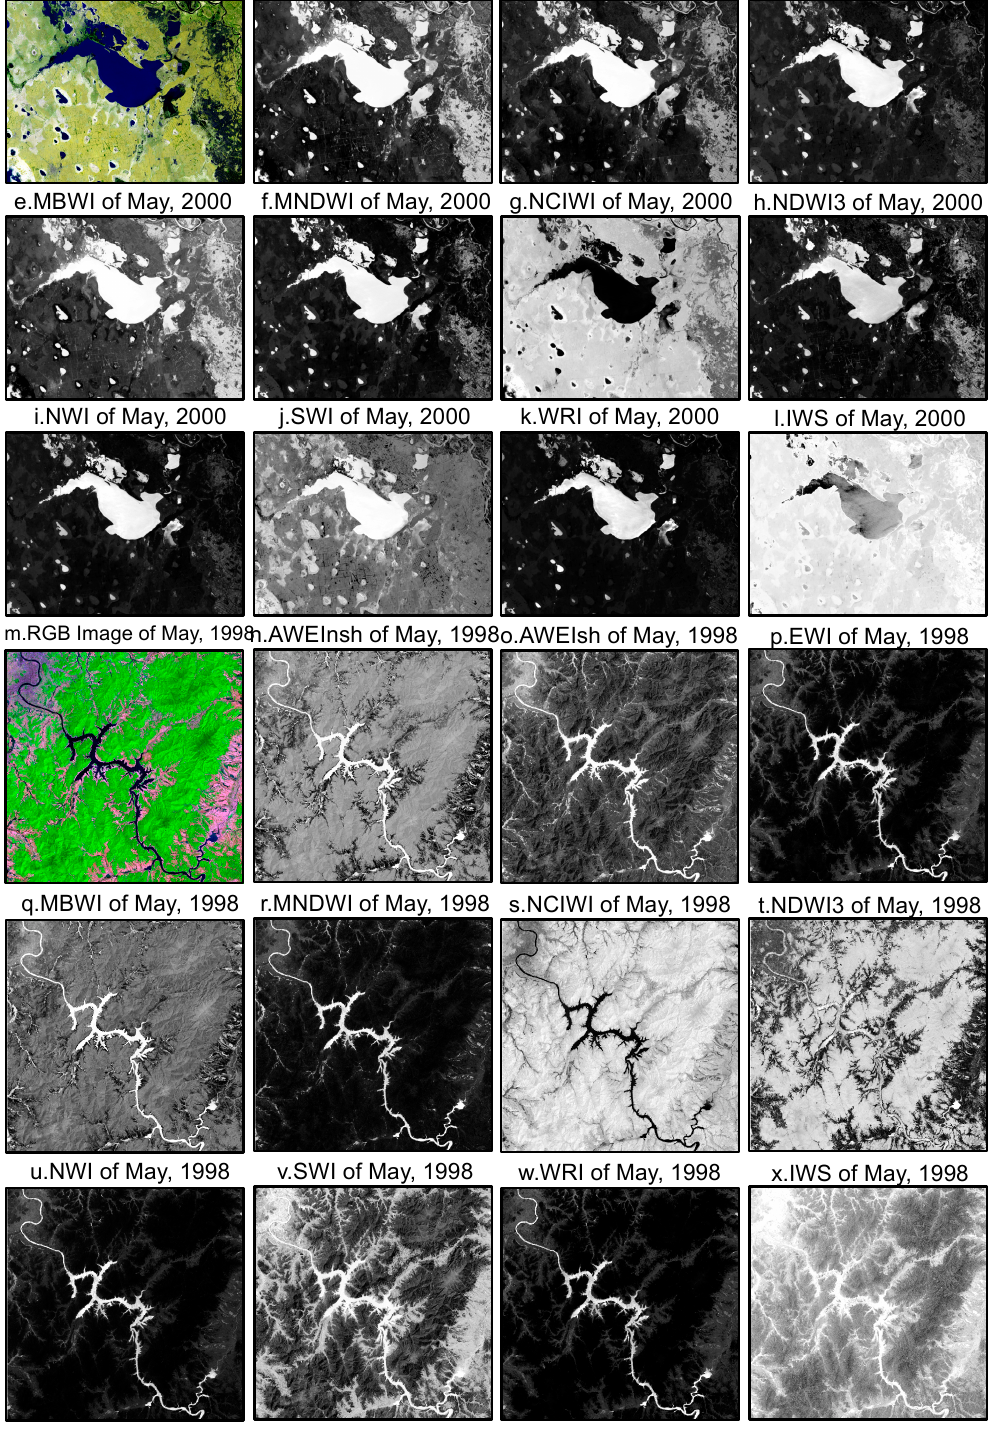
Figure 2. The multispectral image and grayscale images of water indices of May 2000 and 2018. The index images of August 2021 (Chagan Lake area) and 2022 (Songhua Lake area) were selected as an example of the high-water period from July to September, as shown in Figure 3. In the IWS image, only a small part of Chagan Lake and the cloud can be visually recognized, thus failing to identify water (Figure 3l,x). During the high-water pe- riod in study area of Chagan Lake, the values of paddy fi elds and wetlands in most water